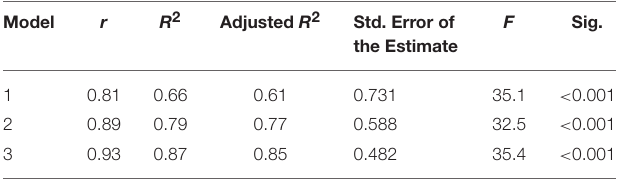
TABLE 2 | Regression model for aLM/ht 2 .